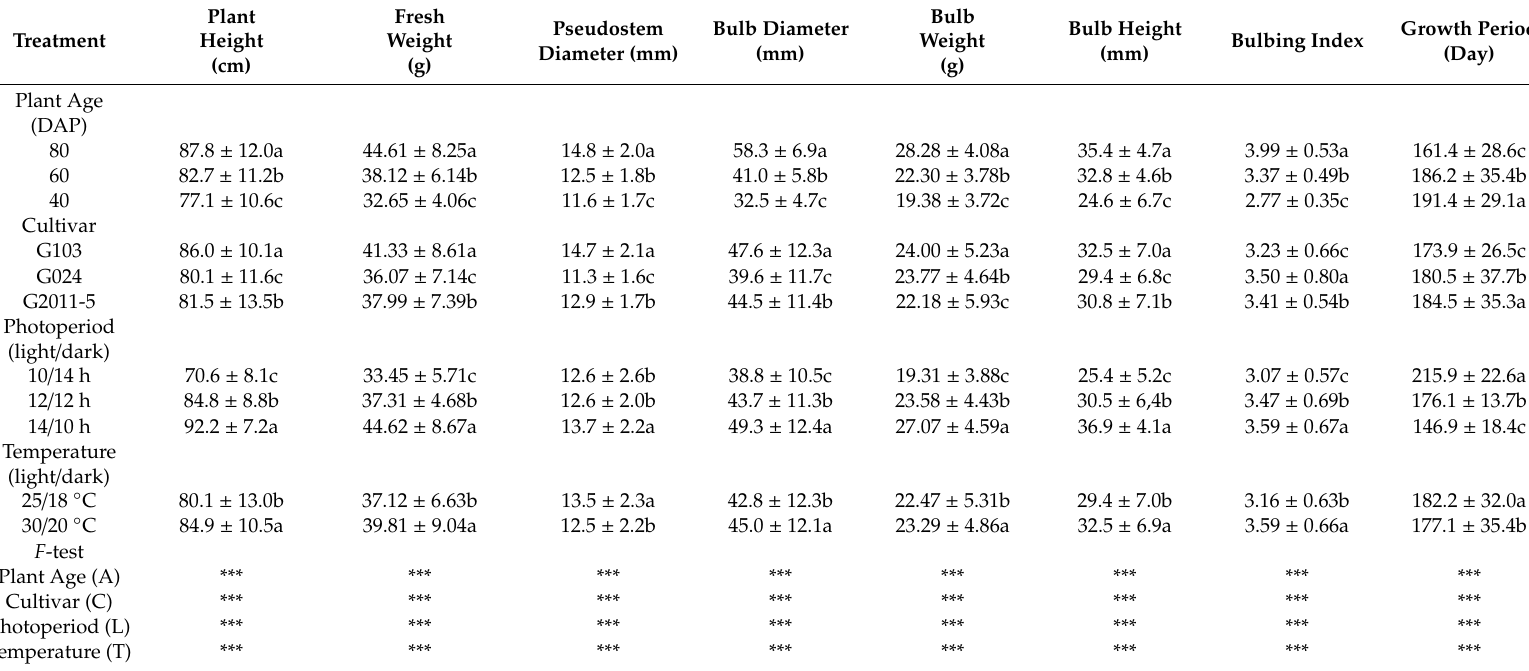
Table 2. E ff ect of plant age, cultivar, photoperiod and temperature treatments on garlic plant morphological traits, bulb characteristics, bulbing index and growth period.